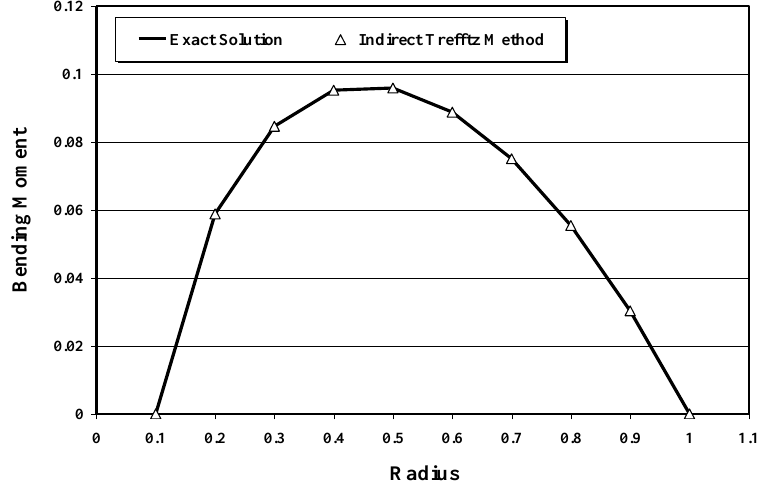
Fig. 4. Bending moment along radius for simply supported annular plate ( b = 0.1 a , h = 0.02 a